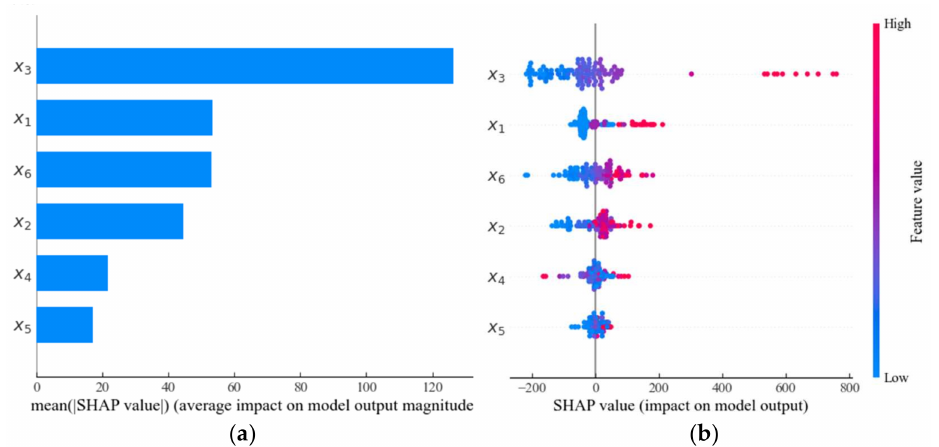
Figure 9. Global interpretations of PSO-SVR model by SHAP values. ( a ) SHAP feature importance; ( b ) SHAP summary